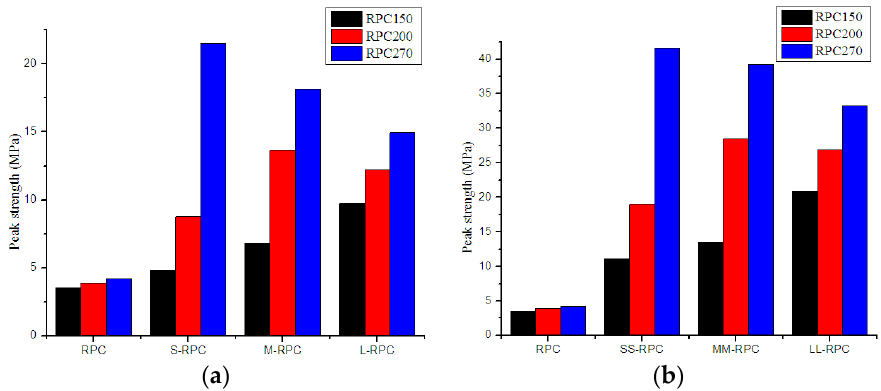
Figure 7. Effects of steel fiber length on peak strength of RPC: ( a ) 0.5% fiber content and ( b ) 2.0% fiber content. Materials 2019 , 12 , x FOR PEER REVIEW